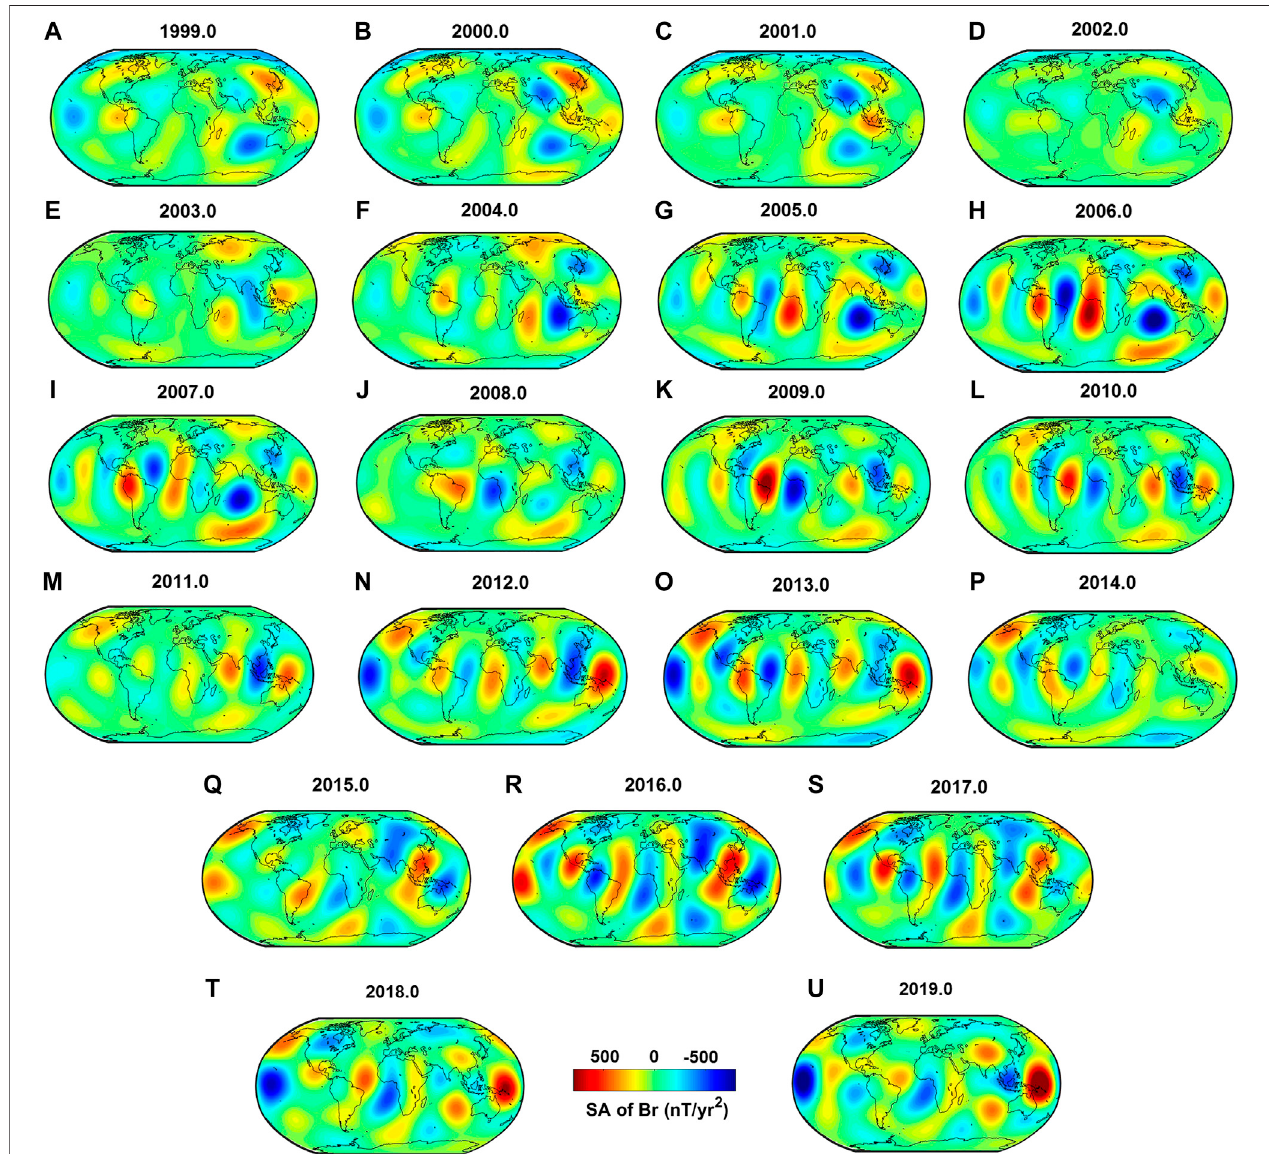
FIGURE6| SecularaccelerationoftheBrofthegeomagnetic fi eldattheCMB.MapsofthesecularaccelerationoftheBratCMBforJanuary1foreveryyearduring the last 2 decades. We use CHAOS-7.2 model until degree six to calculate the Br.